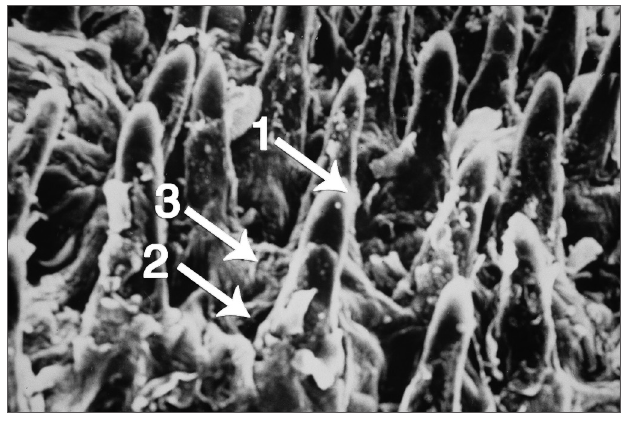
Keywords: histology, taste bud, tongue.